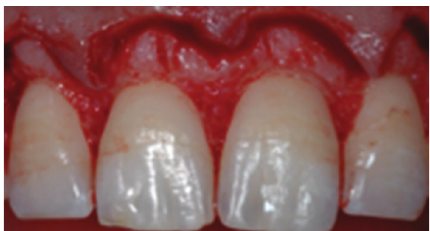
Figure 4: Bone crest at level of